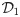
Fitting results for three different datasets.Dataset D1 is the same as in Fig 4, i.e. an HVC neuron from anesthetized Zebra Finch. D3 is from HVC in awake Zebra Finch, and D4 is from mouse visual cortex in awake mouse. The different panels show the results after fitting; in the first line the GP covariance function k(t) (red) and the empirical autocorrelation (black), Eq (14), in the second line the spike-related kernel α(t), in the third line the adaptation kernel η(t), and in the fourth line the inter-spike interval density ρ(t) (data ISI histogram in gray, simulated ISI distribution from AGAPE in red). There are pronounced differences between datasets in all three kernels, showing the flexibility of the AGAPE model in describing a wide range of statistics. All red shaded regions denote ± 2 standard deviations, estimated from the observed Fisher information.